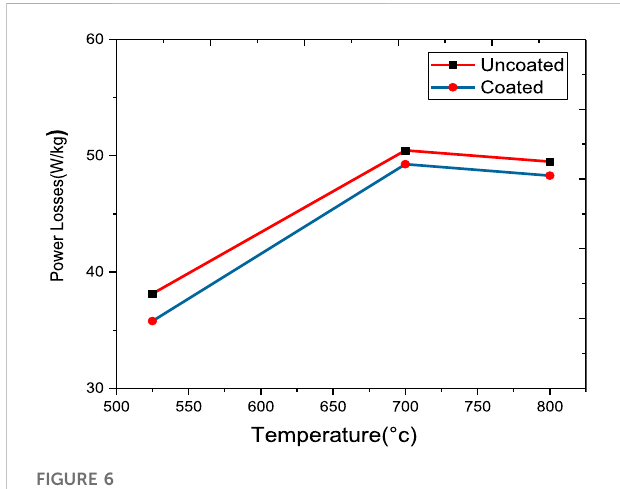
FIGURE 6 Power losses (400 Hz, 1.5 T) for coated and uncoated samples at different